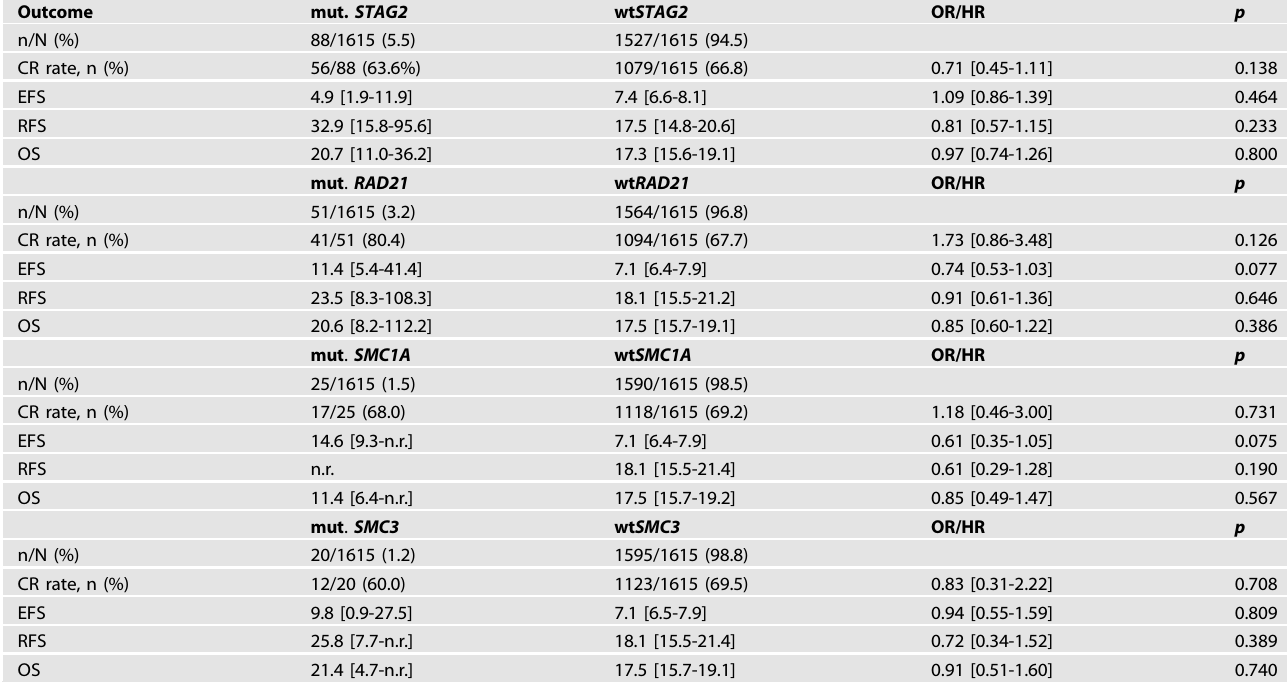
Table 2. Summary of outcomes for AML patients with mutations of cohesin subunit genes. Outcome mut. STAG2